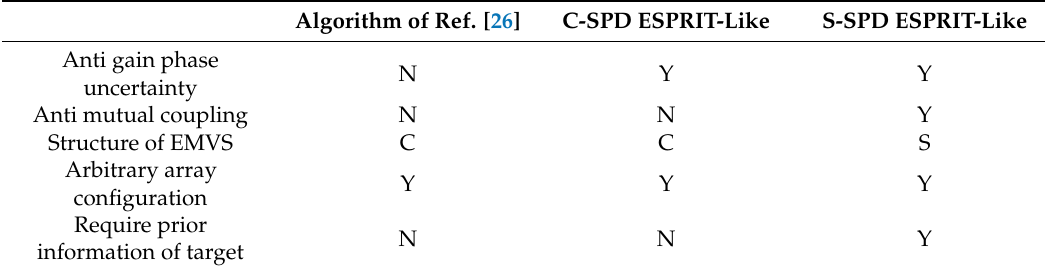
Table 2. Comparison of three